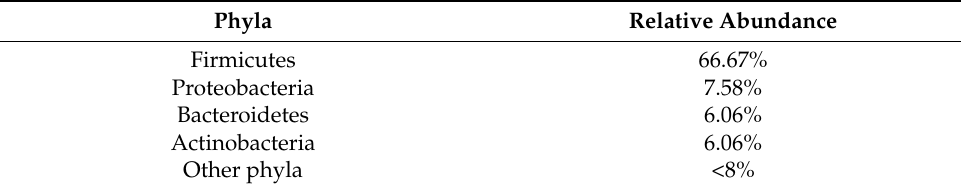
Table 6. Relative abundance of bacterial phyla (combined for all diets).